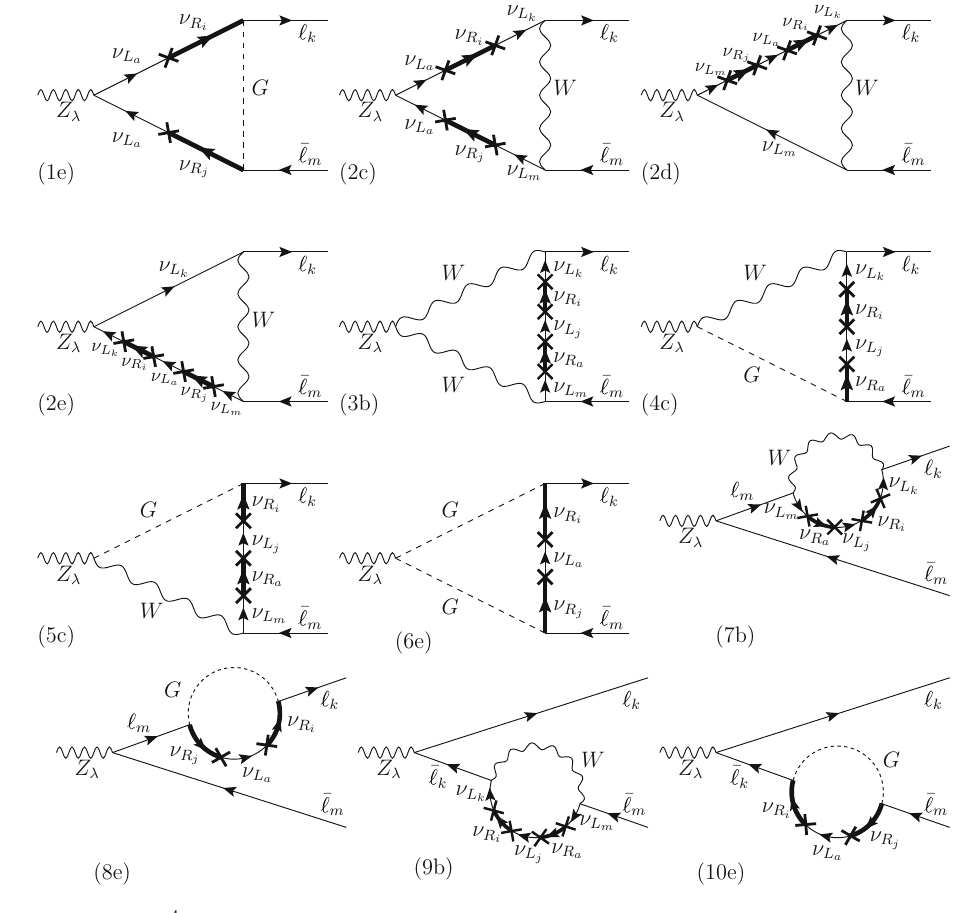
Fig. 4 Relevant diagrams of O ( Y 4 ν ) in a covariant